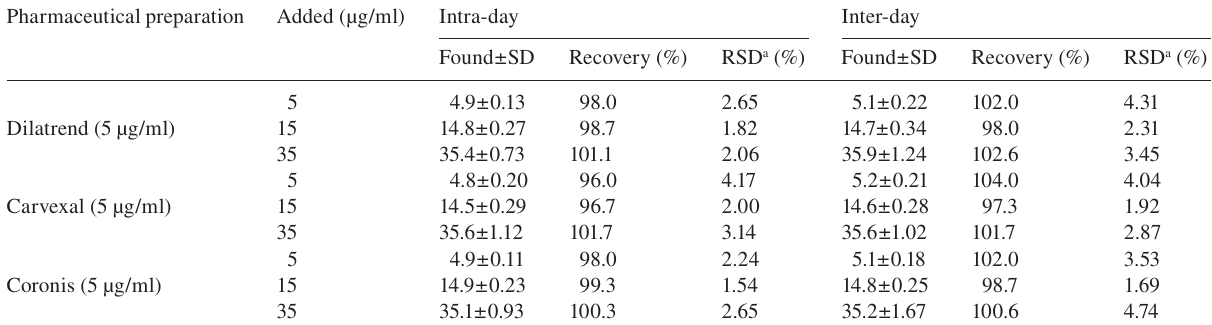
Table 2 Recovery of carvedilol in pharmaceutical preparations. Pharmaceutical preparation